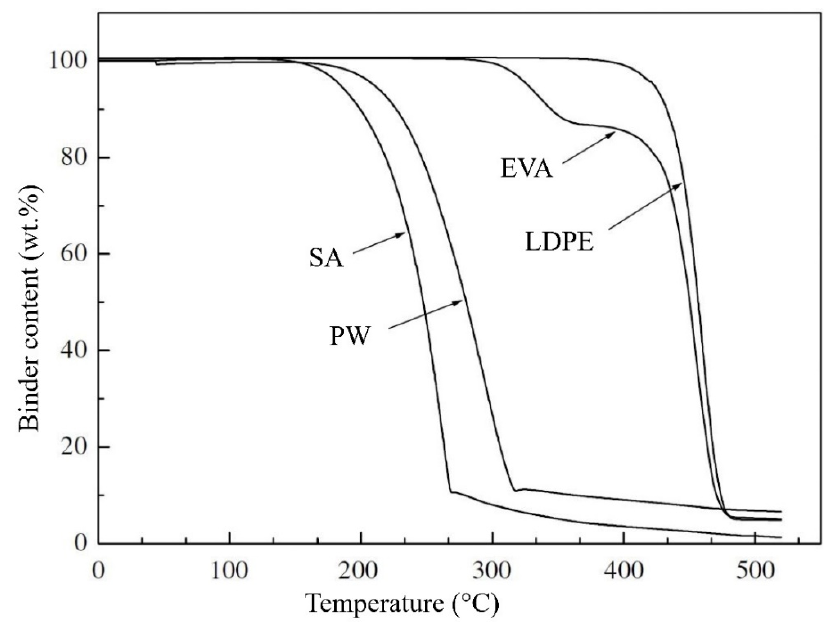
Figure 3. TGA curves of all binder constituents. Reproduced with permission from reference [97], copyright © 2004, Elsevier Ltd.